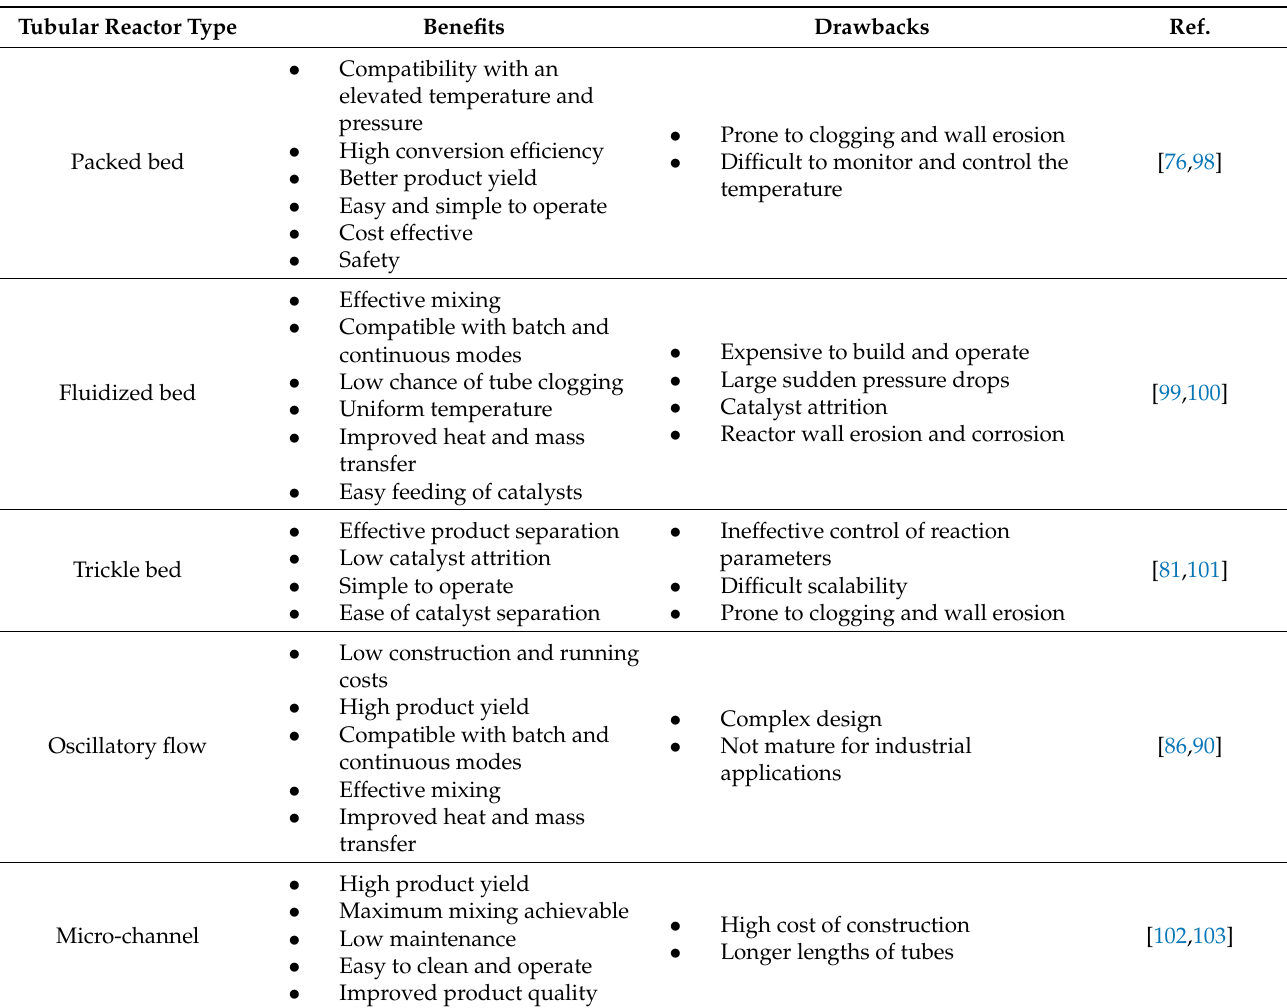
Table 6. Benefits and drawbacks of tubular